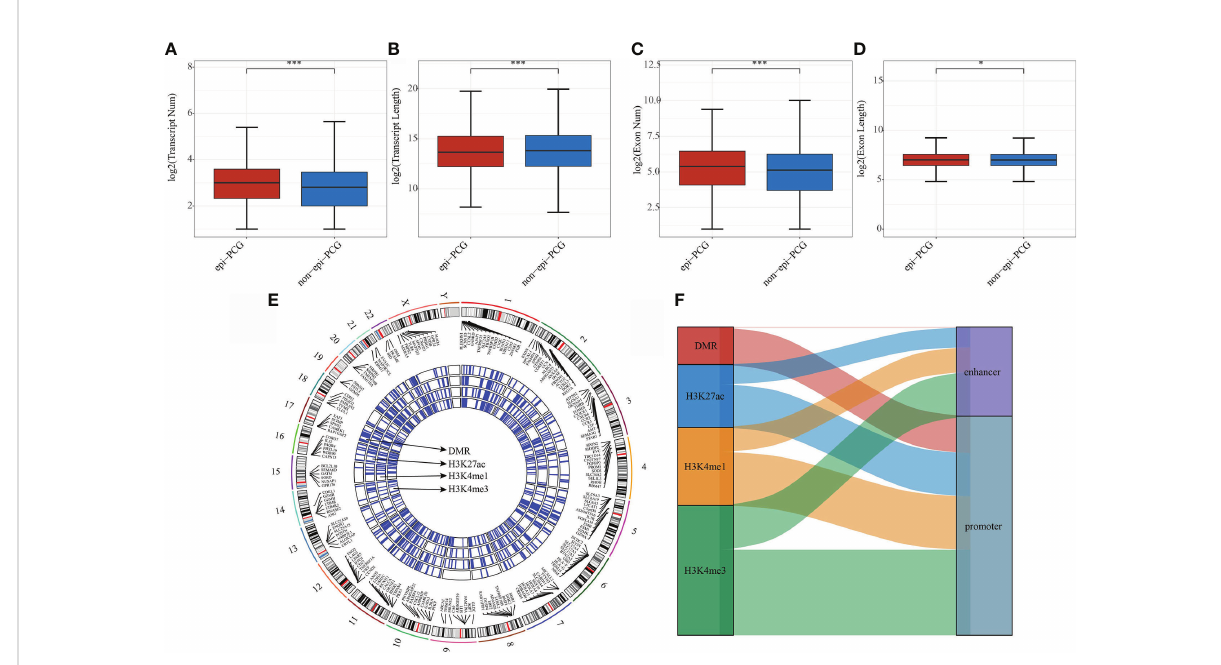
FIGURE 2 Comparison of genomic characteristics of epigenetically dysregulated lncRNA/PCGs (n = 872) and non-epigenetically dysregulated lncRNA/ PCGs (n = 18629). (A) Comparison of the number of transcripts; (B) Comparison of the length of transcripts; (C) Comparison of the number of exons; (D) Comparison of the lengths of exons; (E) Genomic landscape of epi-PCGs characterized by histone modi fi cation; (F) Location distribution of histone modi fi cations of epi-PCGs. *P < 0.05, ***P <